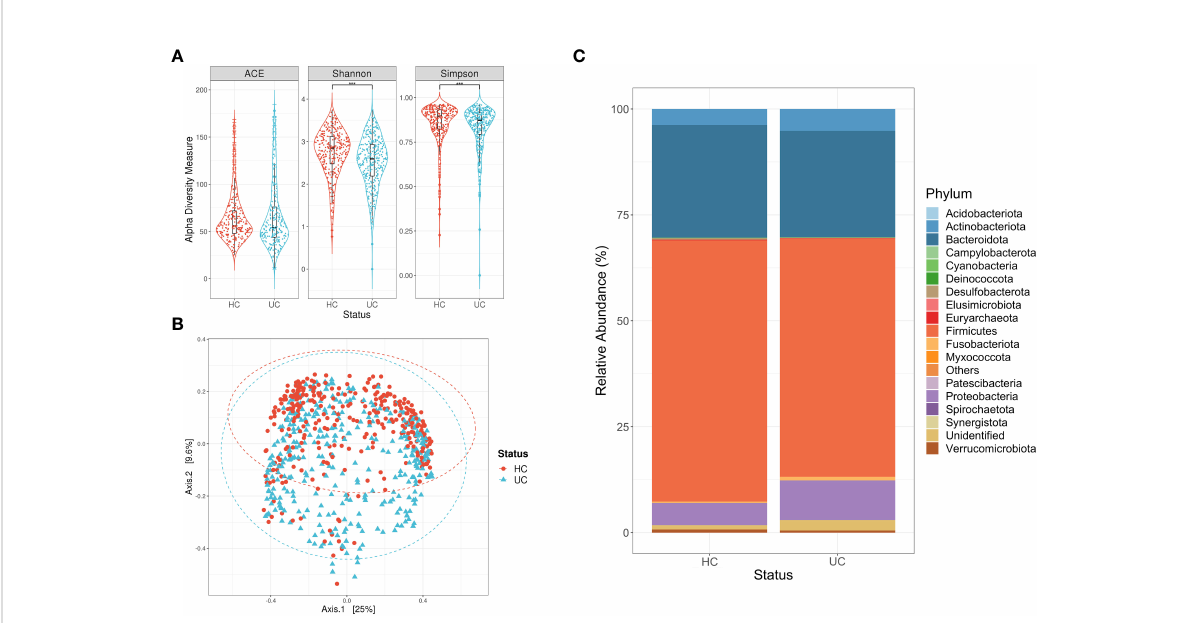
FIGURE 3 Descriptive analysis for the consolidation of studies focused on ulcerative colitis (UC). (A) Alpha diversity measures calculated for the ASVs of subjects with UC and their respective controls (HC). Statistical differences were evaluated with a Mann-Whitney test (***p-vlaue <0.001). (B) Principal Coordinate Analysis (PCoA) for the ASVs of subjects with UC and their respective controls (HC). Statistical differences of beta diversity were evaluated with the adonis test (r 2 = 0.012, p-value <0.01). (C) Relative abundance of the phyla for each of the study groups, where Proteobacteria displays a higher abundance in UC